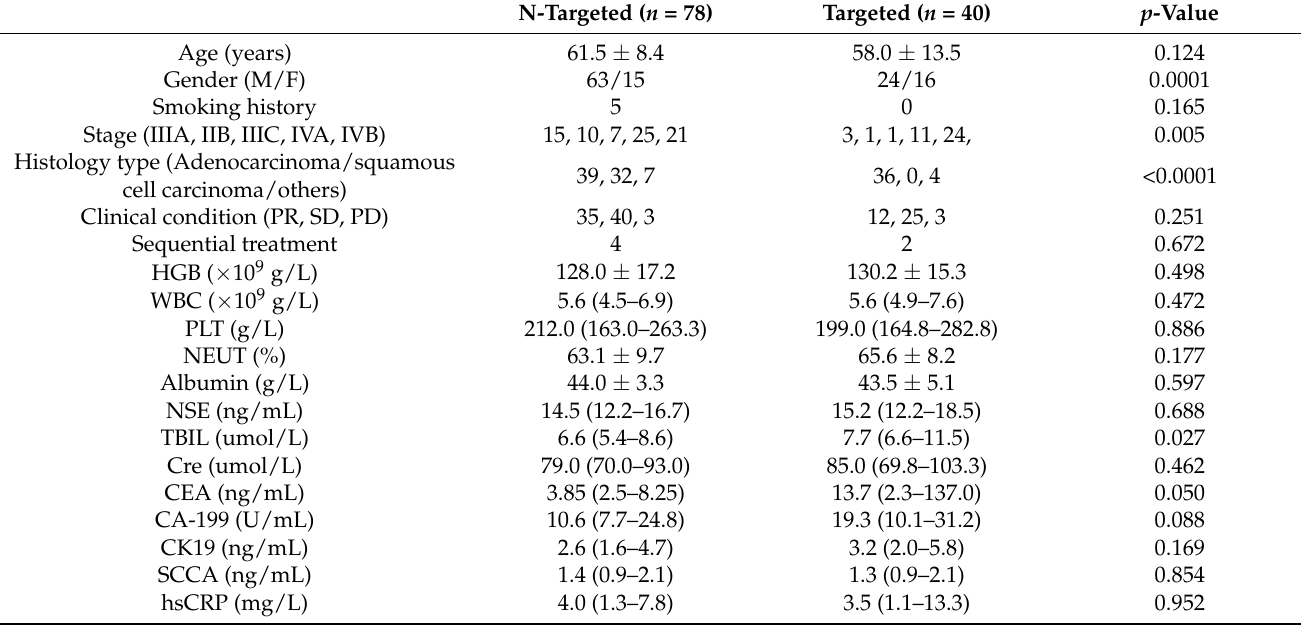
Table 1. Characteristics of patients with NSCLC in different